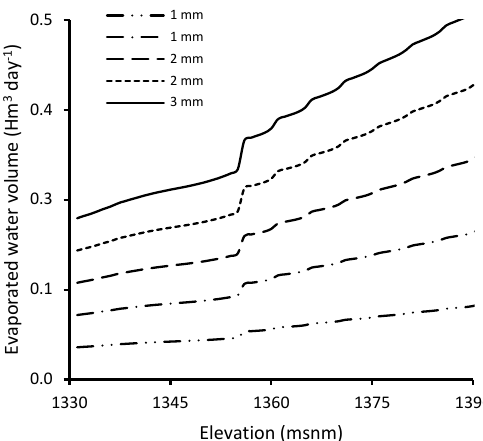
Figure 7. Evaporated water volume with respect to the lake elevation.